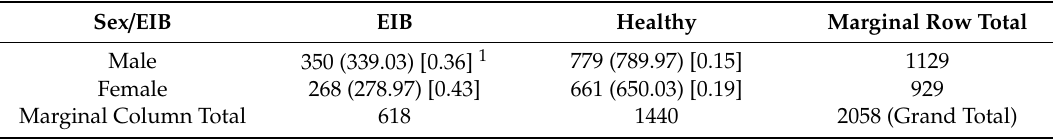
Table 2. Prevalence of EIB in studies incorporating male and female